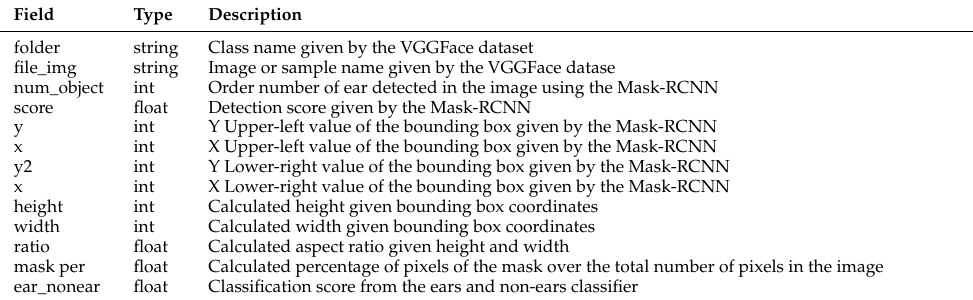
Table 5. Annotation data